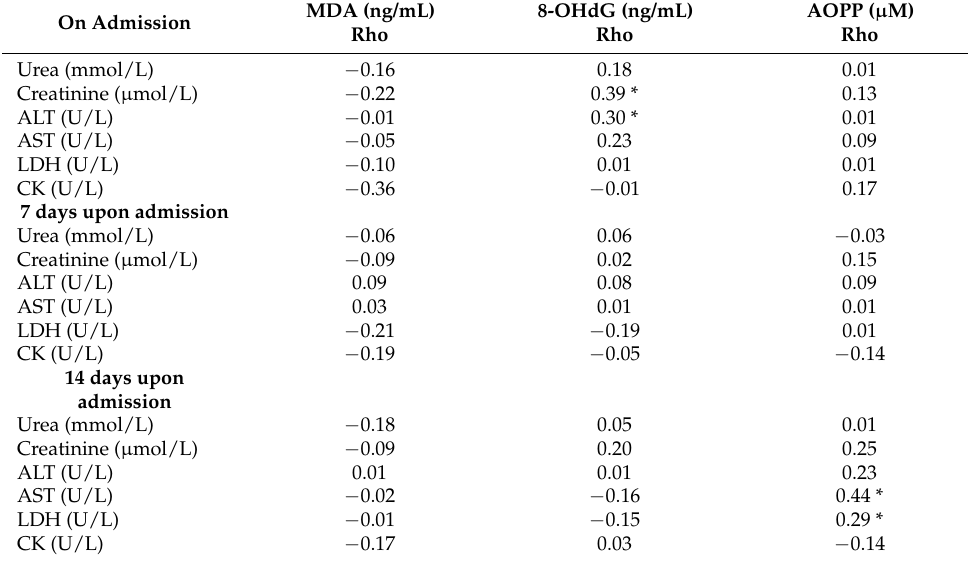
Table 5. Correlation of redox biomarkers with multiorgan impairment biomarkers in 58 patients with COVID − 19 pneumonia on admission, 7 and 14 days upon